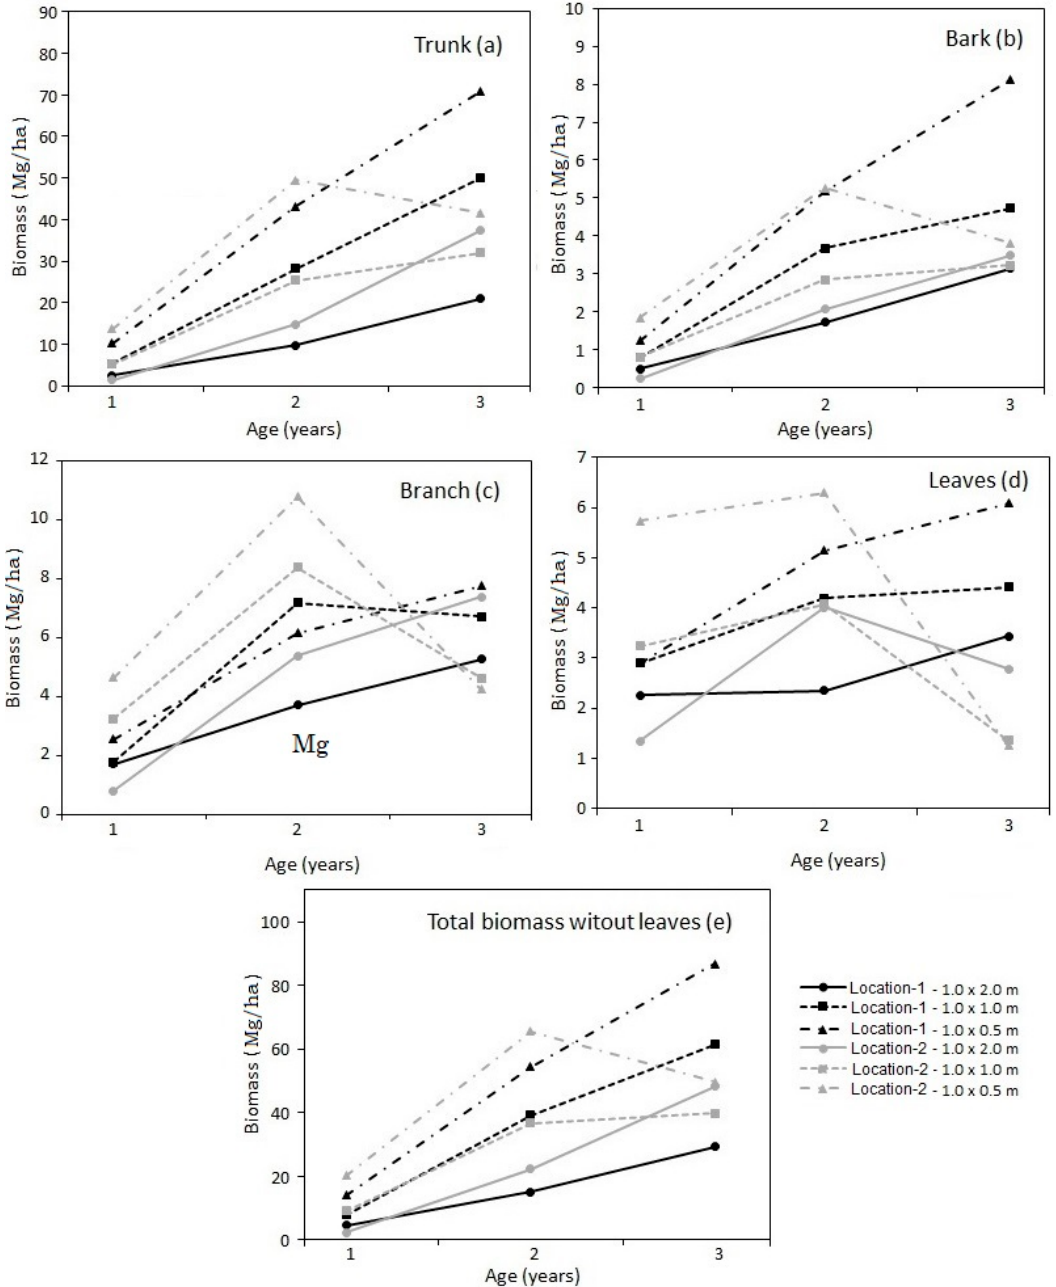
Figure 3. Biomass distribution in the trunk ( a ), in the bark ( b ), in the branch ( c ), in leaves ( d ) and total biomass without leaves ( e ) per hectare in short rotation Gmelina arborea plantations in two different location in Costa Rica.